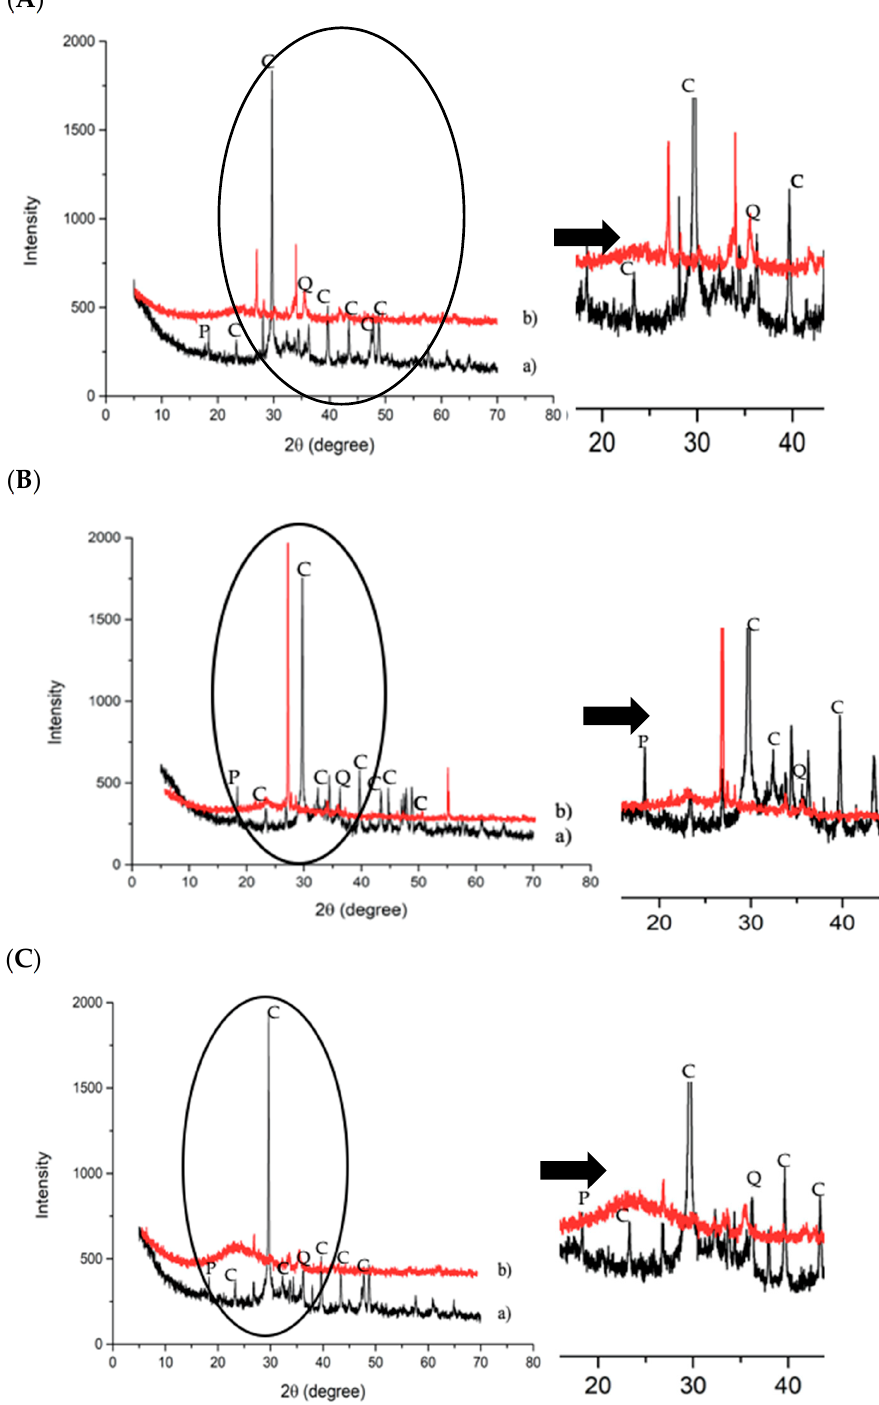
Figure 12. XRD pattern of AAM (a) and AAM after HCl (b): ( A ) M1 ( B ) M2 and ( C ) M3 (Q = quartz; C = calcite; P = portlandite).